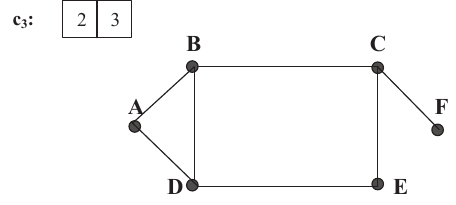
Figure 4. Channel Graph for c